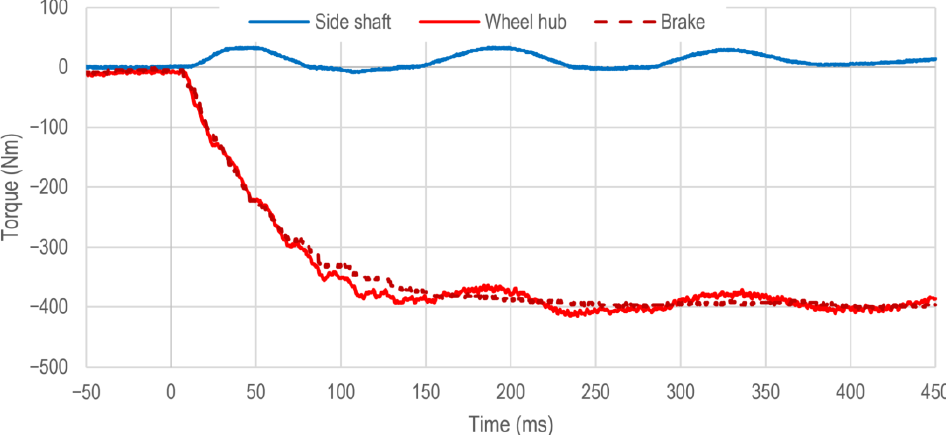
Figure 12. Braking operation with a conventional vehicle braking system from 25 km/h with deactivated anti-jerk control.